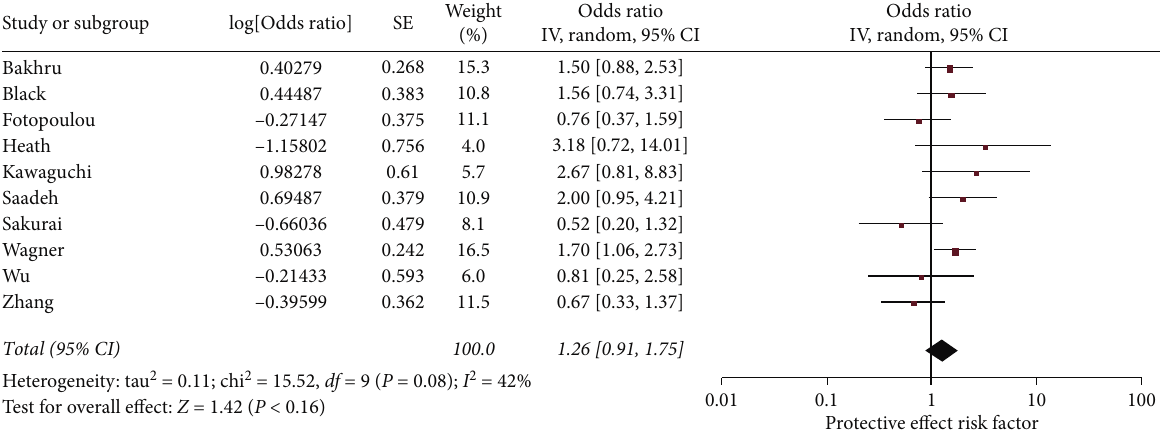
Figure 3: Forest plot of the odds of VTE in ovarian cancer patients that have serous histology tumors (versus nonserous histologies). This figure shows the pooled odd of serous histology (versus nonserous histology). The total pooled odds are 1.26 (0.91–1.75). Study or subgroup